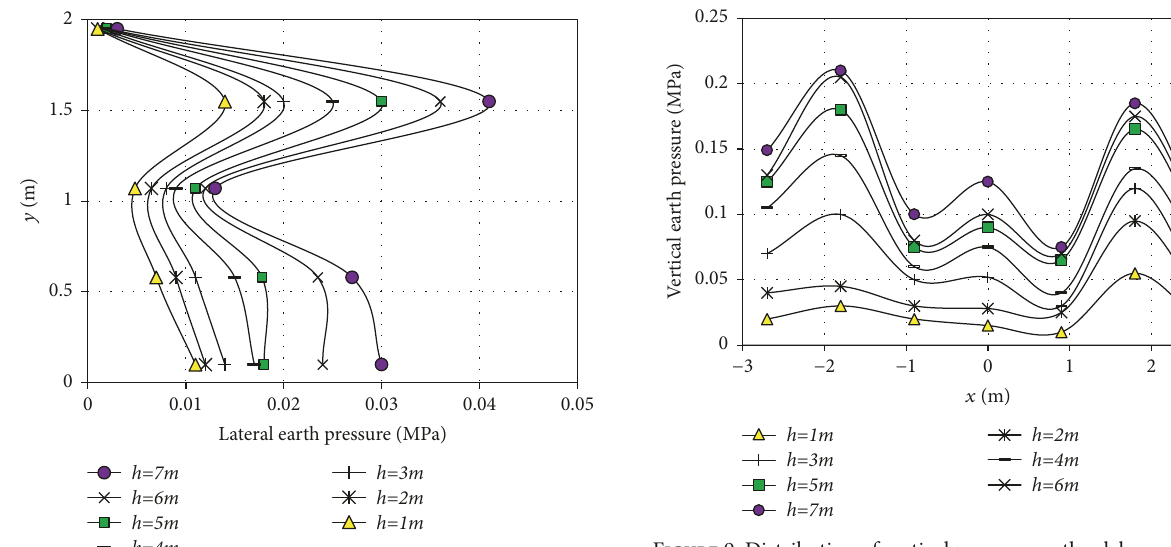
Figure 9: Distribution of vertical pressure on the slab on section II.